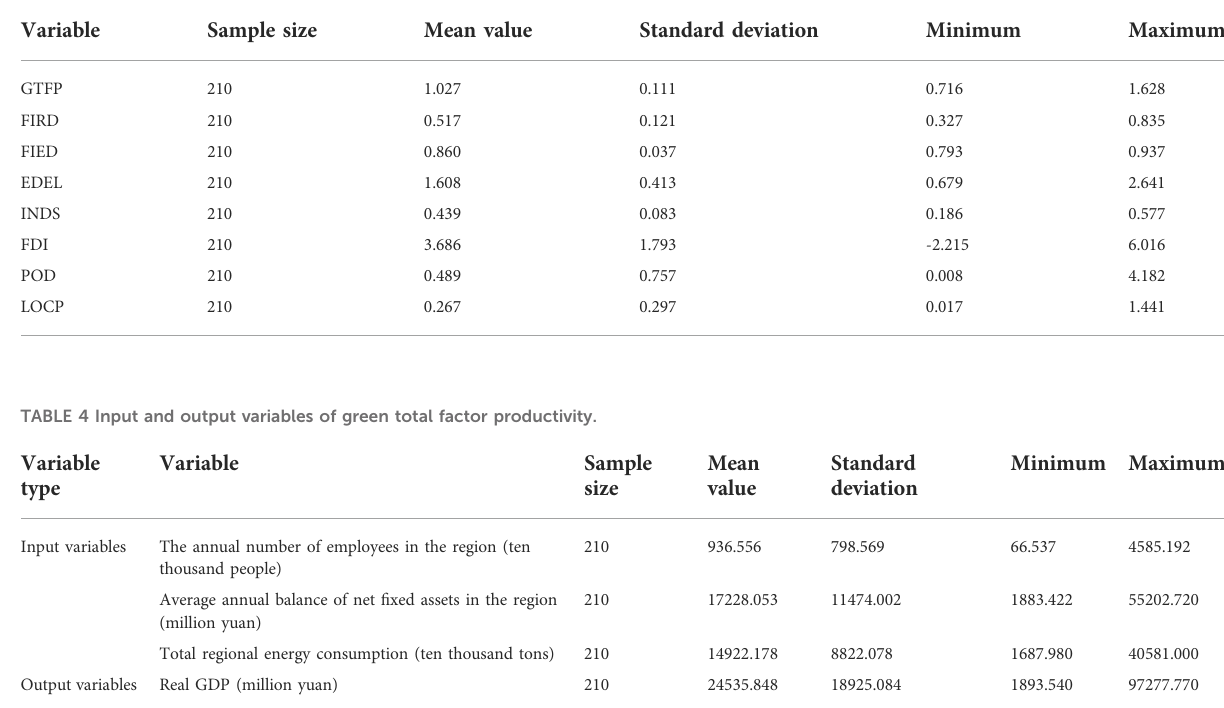
TABLE 3 Descriptive statistics of the main variables.